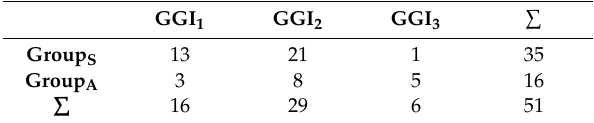
Table 8. Contingency table with the frequencies of GGI 1-3 and Group S,A